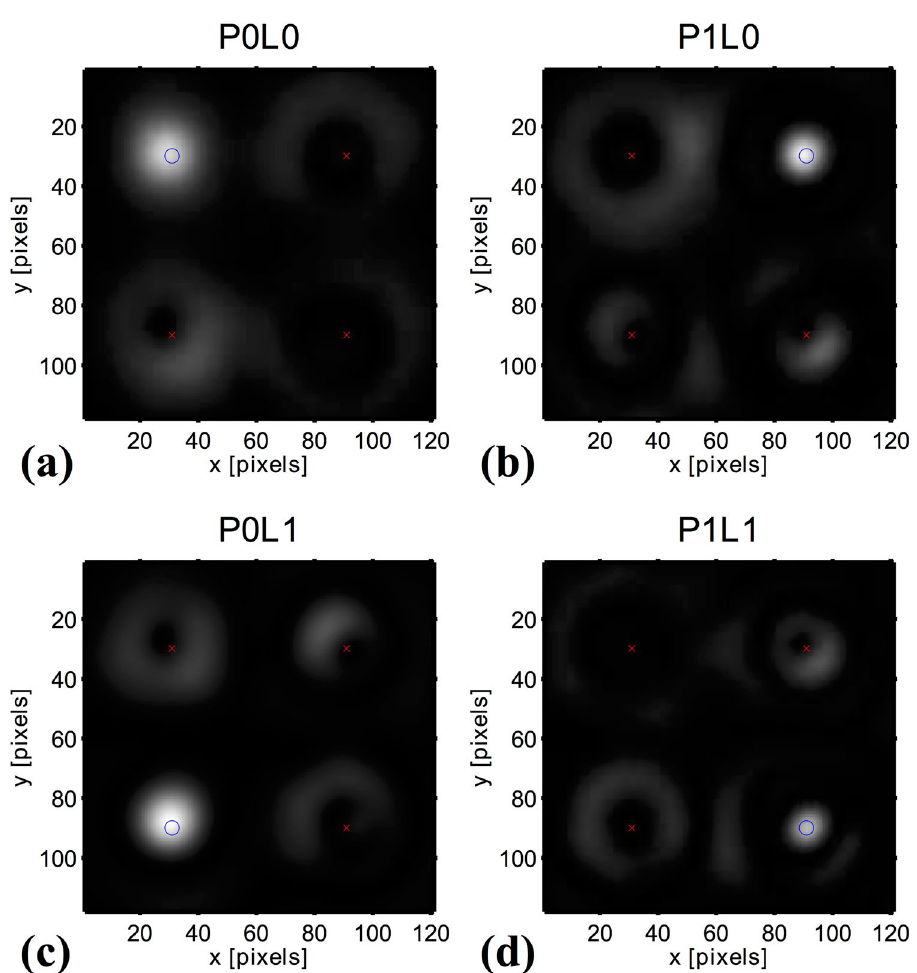
Figure 4. The eigenmask calculated from the measurements, ( a ) in the spatial domain as sent to the spatial light modulator, and ( b ) its Fourier transform. The intensity and hue indicate respectively the amplitude and argument of the complex